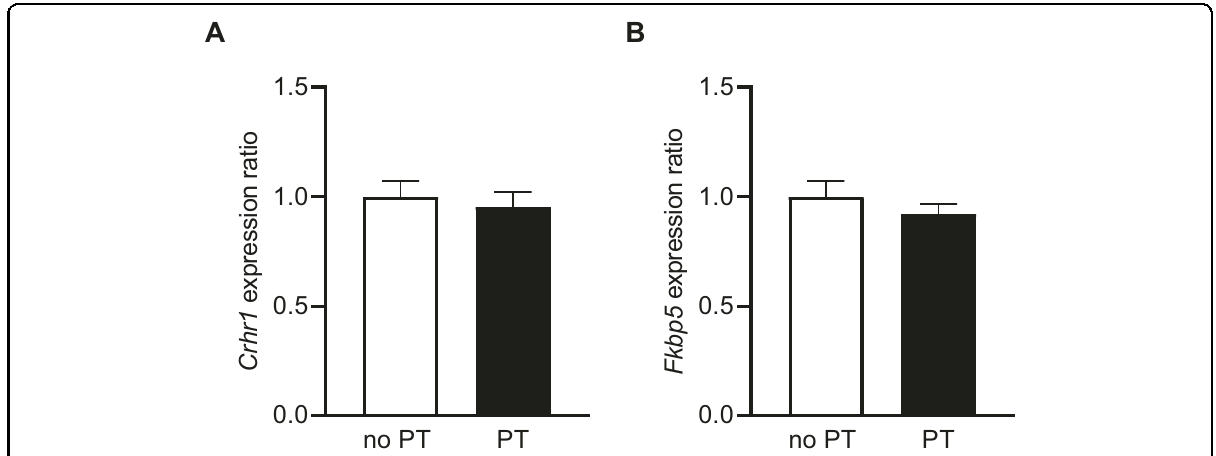
Fig. 5 Expression analysis of Crhr1 and Fkbp5 in the dHPC of PT fetuses compared to a no PT control group. Expression analysis of A Crhr1 and B Fkbp5 in the dHPC of male fetuses on GD 18 revealed no PT-related alterations. See “ Results ” for detailed statistical